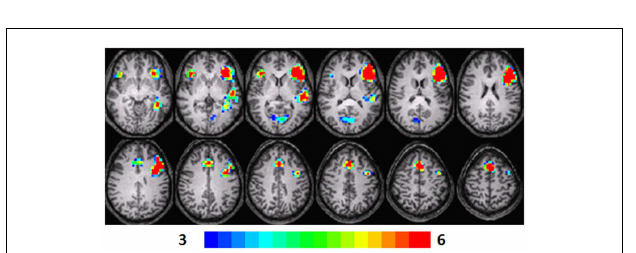
FIGURE 2 | Composite fMRI activation maps for the verb generation (verb generation > finger tapping) inT2 children ( N = 16). The contrast is significant at p < 0.001 (corrected), slice thickness is 5mm for these contiguous slices. Slices range from z = 13 to 24 in theTalairach frame. Cluster size is 30 voxels. Higher significance is indicated in hotter color ( t threshold ranged from 3 to 6). Figure is presented in a radiological orientation (L = R, R = L).